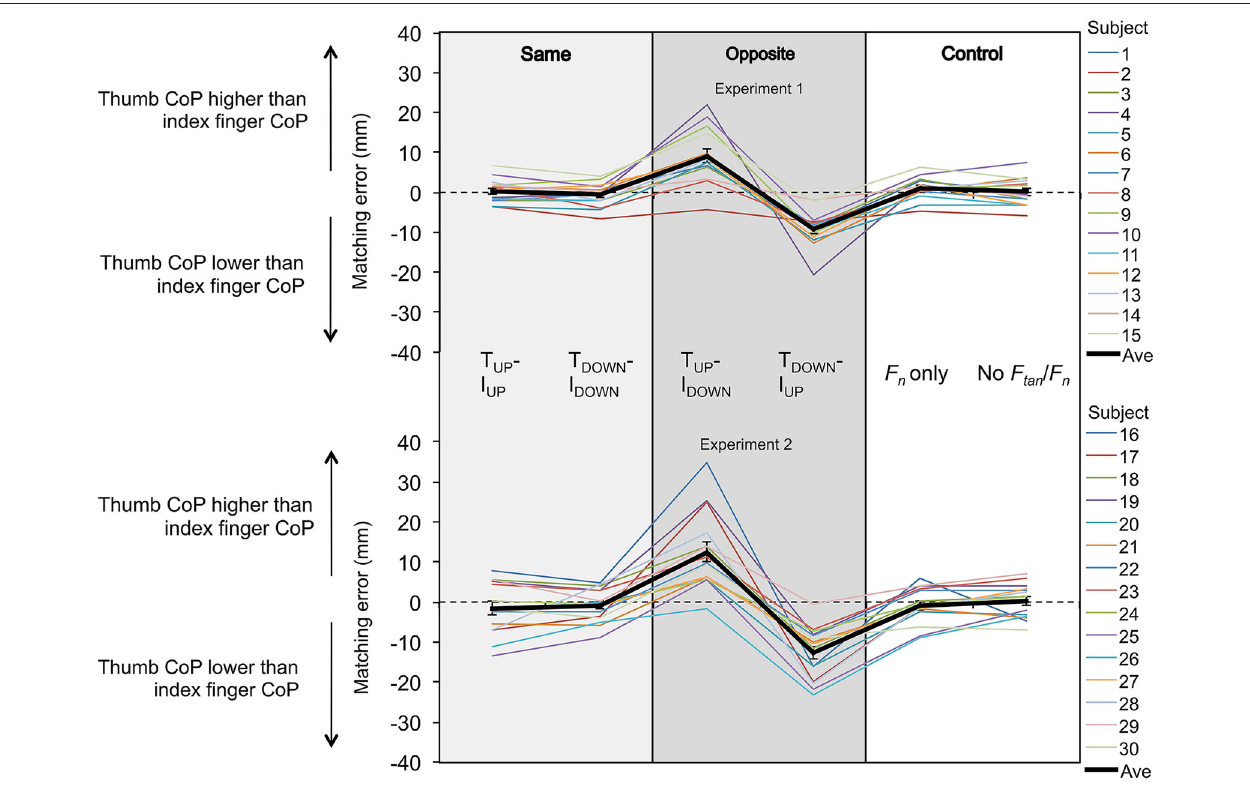
mean matching error averaged across 15 subjects ± standard error of the mean. For both experiments, positive and negative matching errors indicate that subjects reproduced remembered reference hand d y by placing the thumb CoP higher and lower, respectively, than the index finger